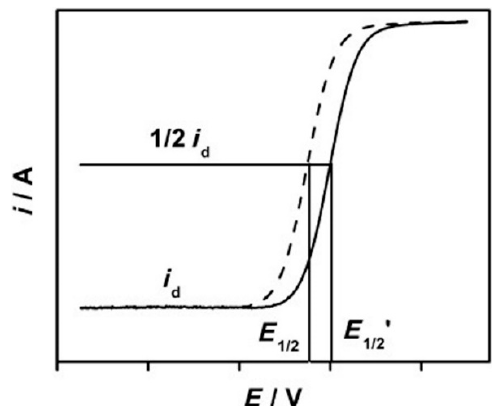
Figure 3. Polarization curve of two different catalysts in the oxygen reduction reaction (ORR) and the essential parameters which are needed for qualitative and quantitative analysis of their performances. Reproduced with permission from Ref. [80]. Copyright Angewandte Chemie International Edition 2013.